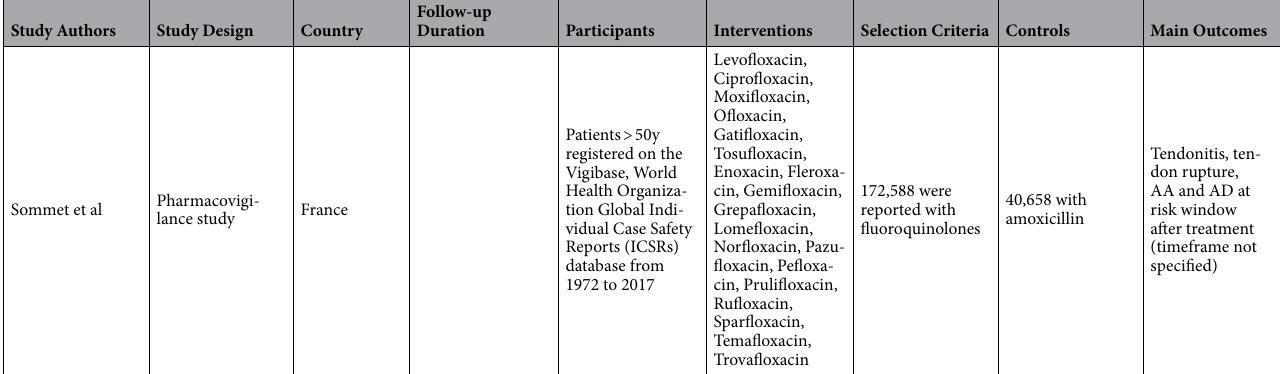
Table 1. Study design of included studies.